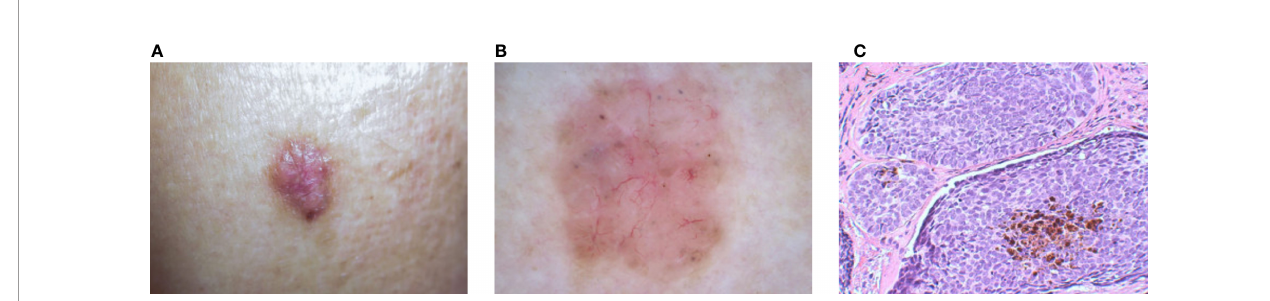
FIGURE 1 | Examples of three types of dermatological images of BCC to show their differences and relationships: (A) Clinical image. (B) Dermoscopy image. (C) Histopathological image.